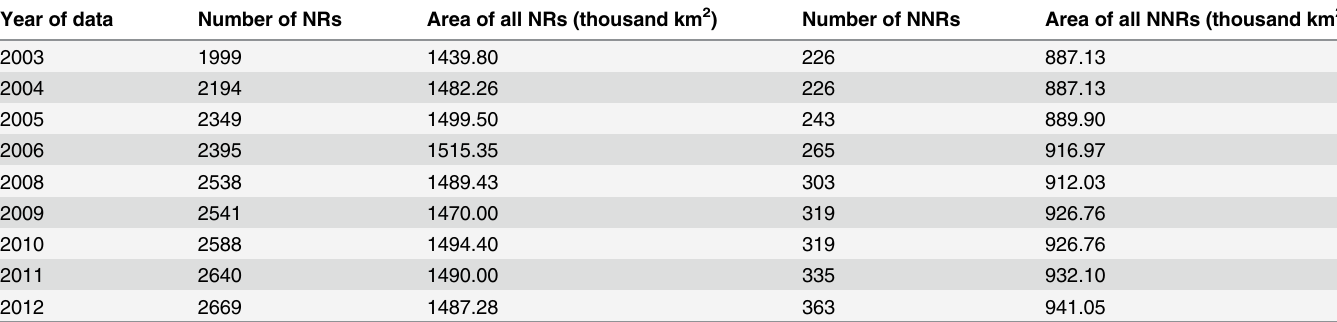
S1 Table. Super-large and extra-large NNRs in mainland